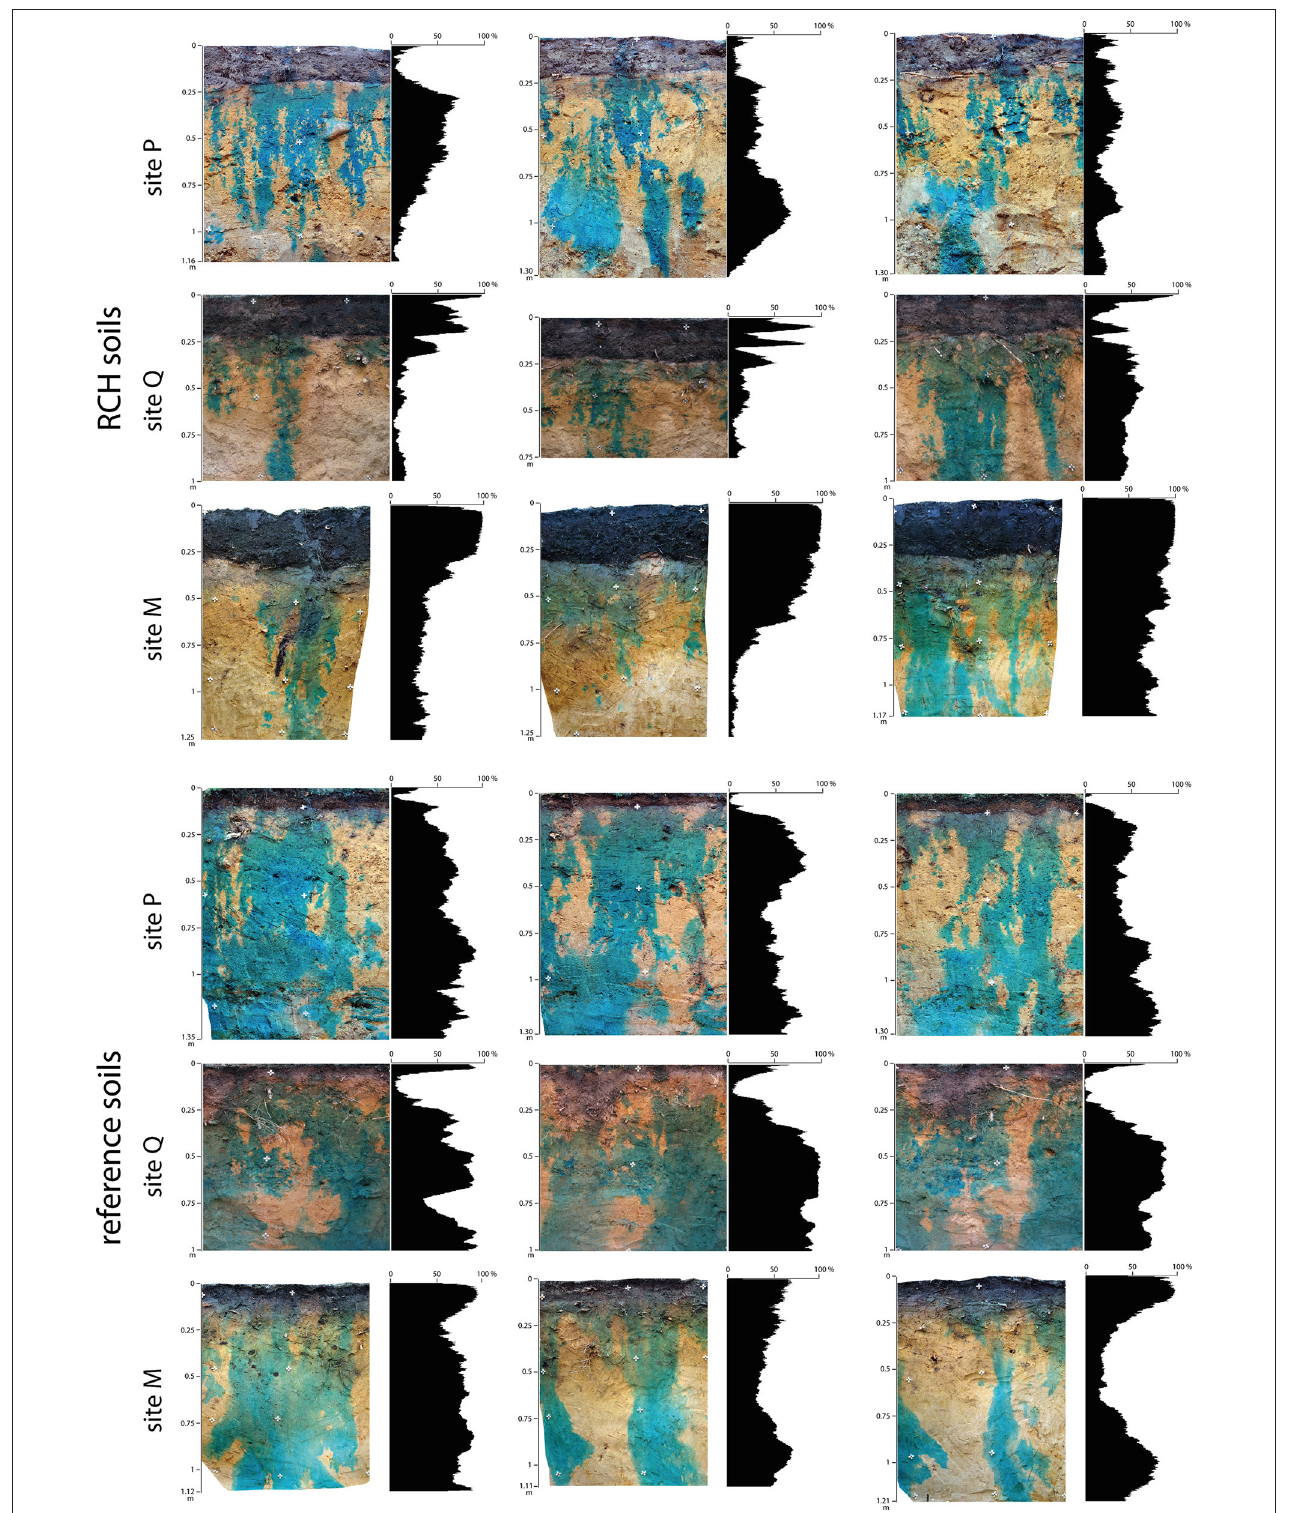
FIGURE 4 | Dye tracer stain patterns in profile photos and plots of horizontally integrated one-dimensional vertical values of relative dye coverage vs. depth for vertical soil profiles on the four experimental plots.